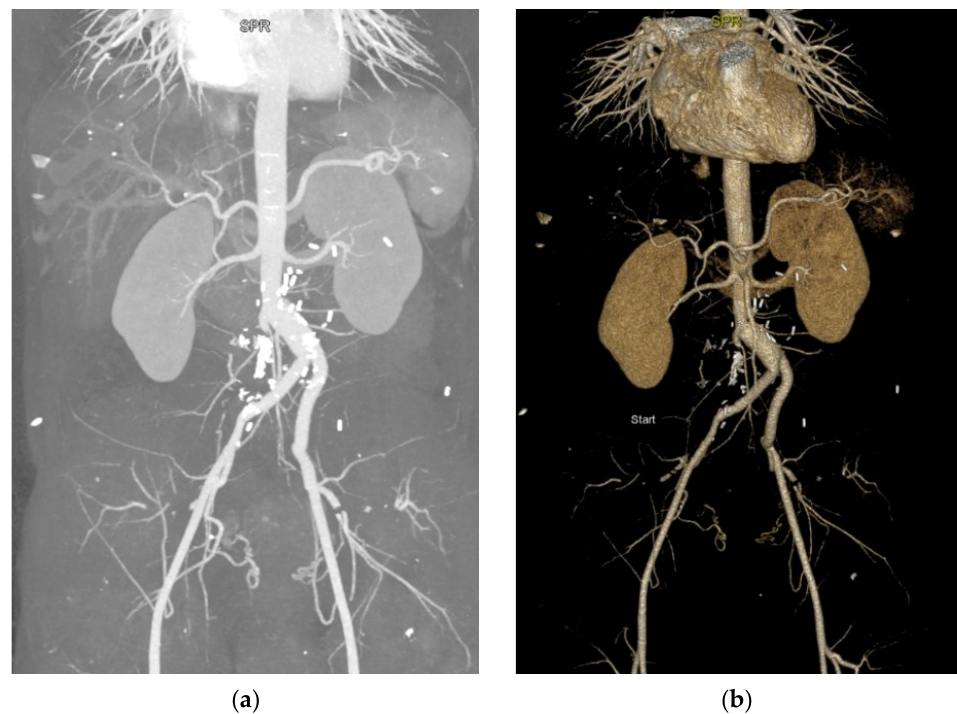
Figure 2. ( a ) Post-aortoiliac bypass arteriographic image; diffuse arterial calcifications; and ( b ) 3D reconstruction of arteriographic image of aortoiliac bypass. The cardiologist recommended throm- bophilia re-evaluation. The screening for acquired thrombophilia—including anti-cardiolipin IgM and IgG antibodies and lupus anticoagulant factor—was negative. Protein C, protein S, homocysteine and antithrombin levels were tested, with no significant changes detected. Factor V Leiden and prothrombin gene mutation were absent. Thus, the inherited thrombophilia diagnosis could not be sustained. The patient was redirected to the vascular surgery department for revascularization. At discharge, antiplatelet therapy (acetylsalicylic acid, 75 mg daily), antihypertensive therapy (can- desartan, 16 mg daily), proton pump inhibitor therapy (pantoprazole, 20 mg daily), statin therapy (atorvastatin, 10 mg daily), and cilostazol (100 mg daily) were prescribed. The patient underwent aorto-iliac Dacron graft bypass surgery (this figure). The postoperative evolution was favorable. The patient experienced digestive discomfort under antiplatelet therapy with 75 mg acetylsalicylic acid tablets. In consequence, augmentation to a new dosage form of 100 mg tablets was decided. This pharmacological product ensured the same antiaggregant effect, but with better gastrointestinal tolerability, due to the different pharmaceutical excipients found in the composition. Statin therapy was increased to 80 mg atorvastatin daily for two months, then 40 mg daily for an indefinite period. Antihypertensive therapy with 16 mg candesartan daily was